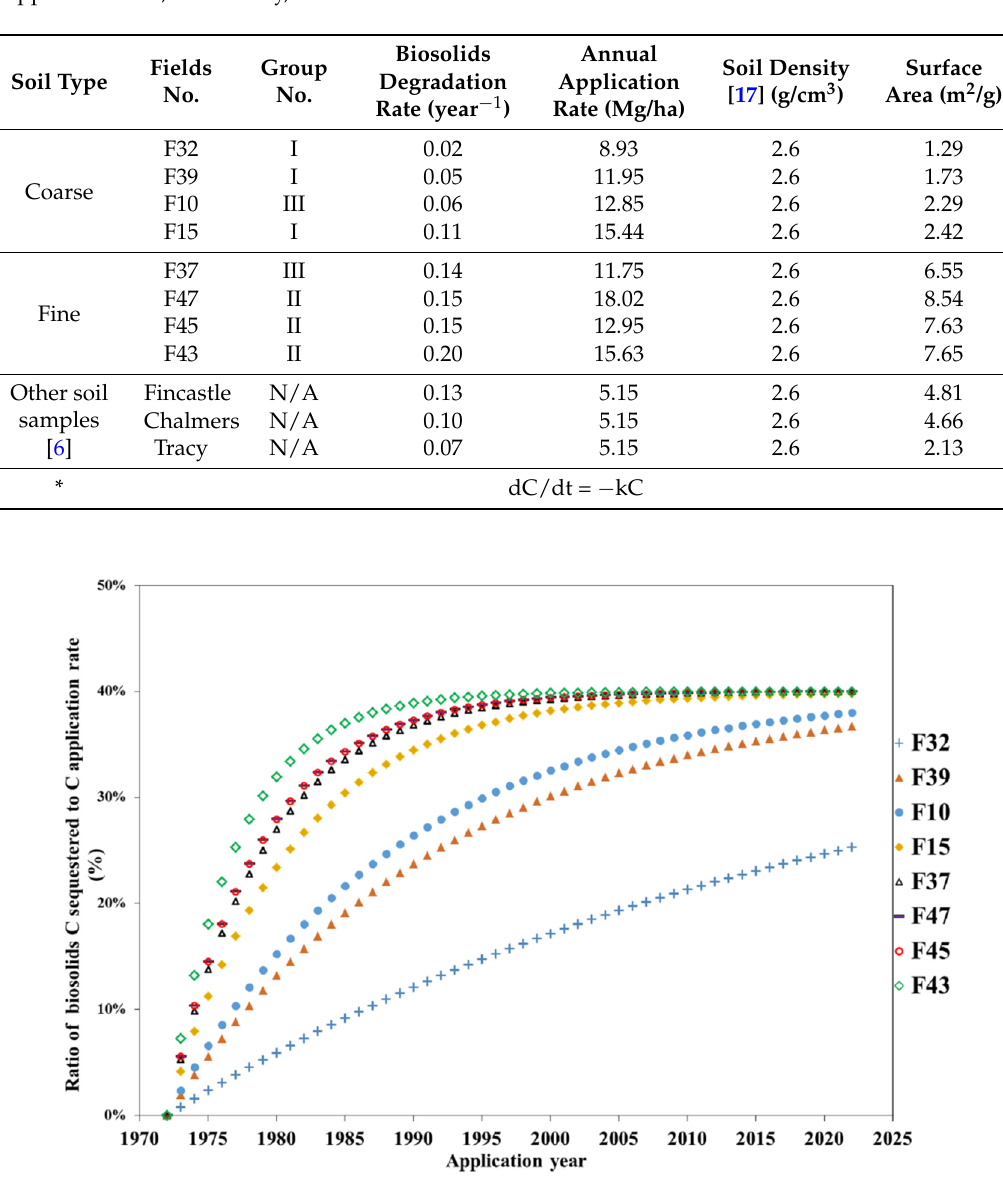
Table 1. Variation in the first order biosolids degradation rate (from Equation (1)* in DRM), annual application rate, soil density, and surface area for soils evaluated.